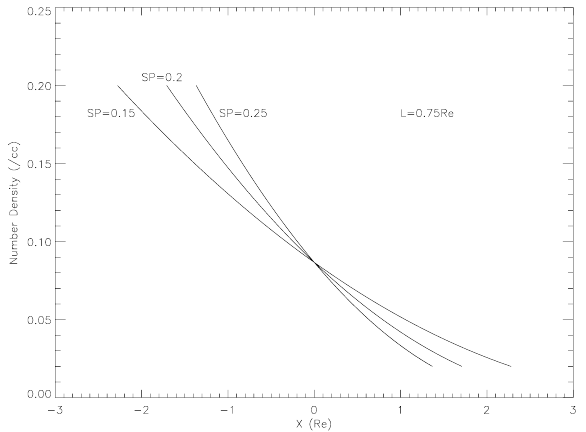
Fig. 5. Growth rate as the function of wave number for each back- ground medium (SP=0.2). Each labeled line indicates an unstable